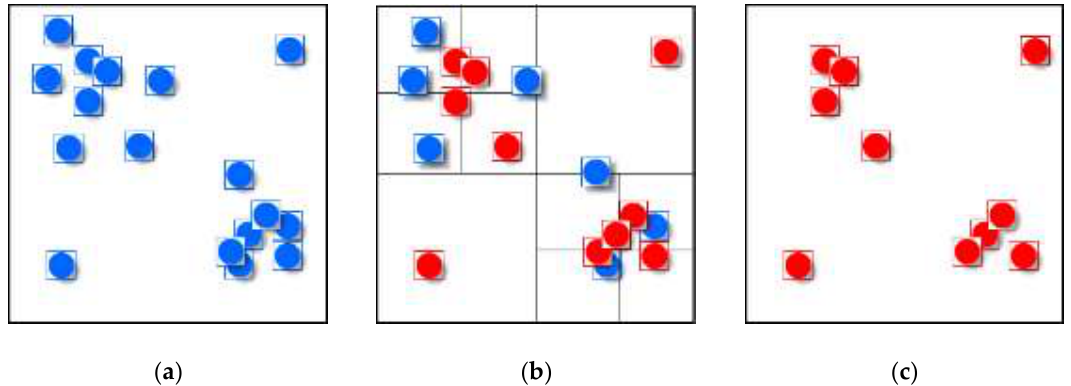
Figure 4. Discovery of spatial structure of a point group and extracting feature points easily by using selection operator: ( a ) original state of point group; ( b ) space is divided into several density units by quadtree grids and only one point will be selected in each grid; ( c ) feature points that conserve the spatial structure of the original point group are selected, the rest points will be further processed.